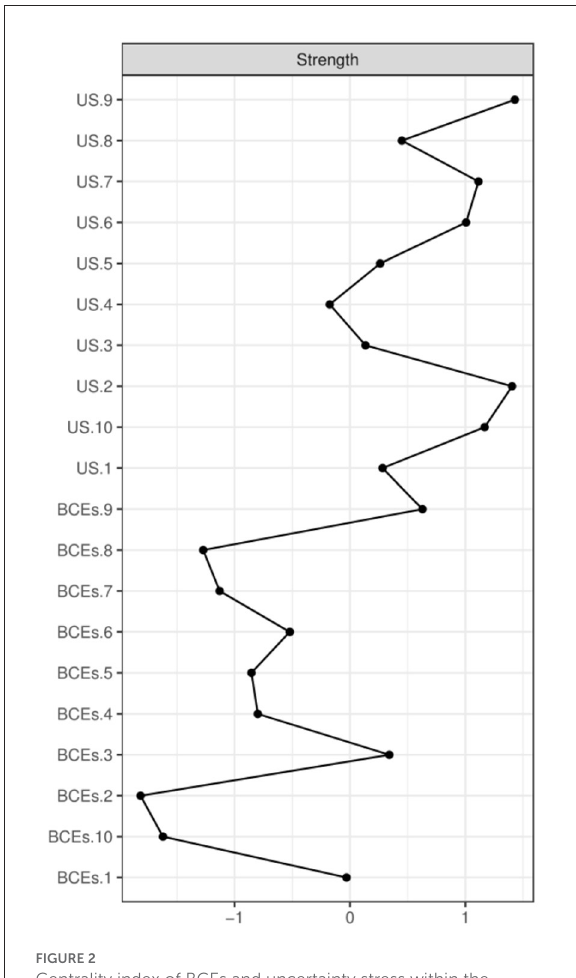
FIGURE2 Centrality index of BCEs and uncertainty stress within the network, shown as standardized values z scores.